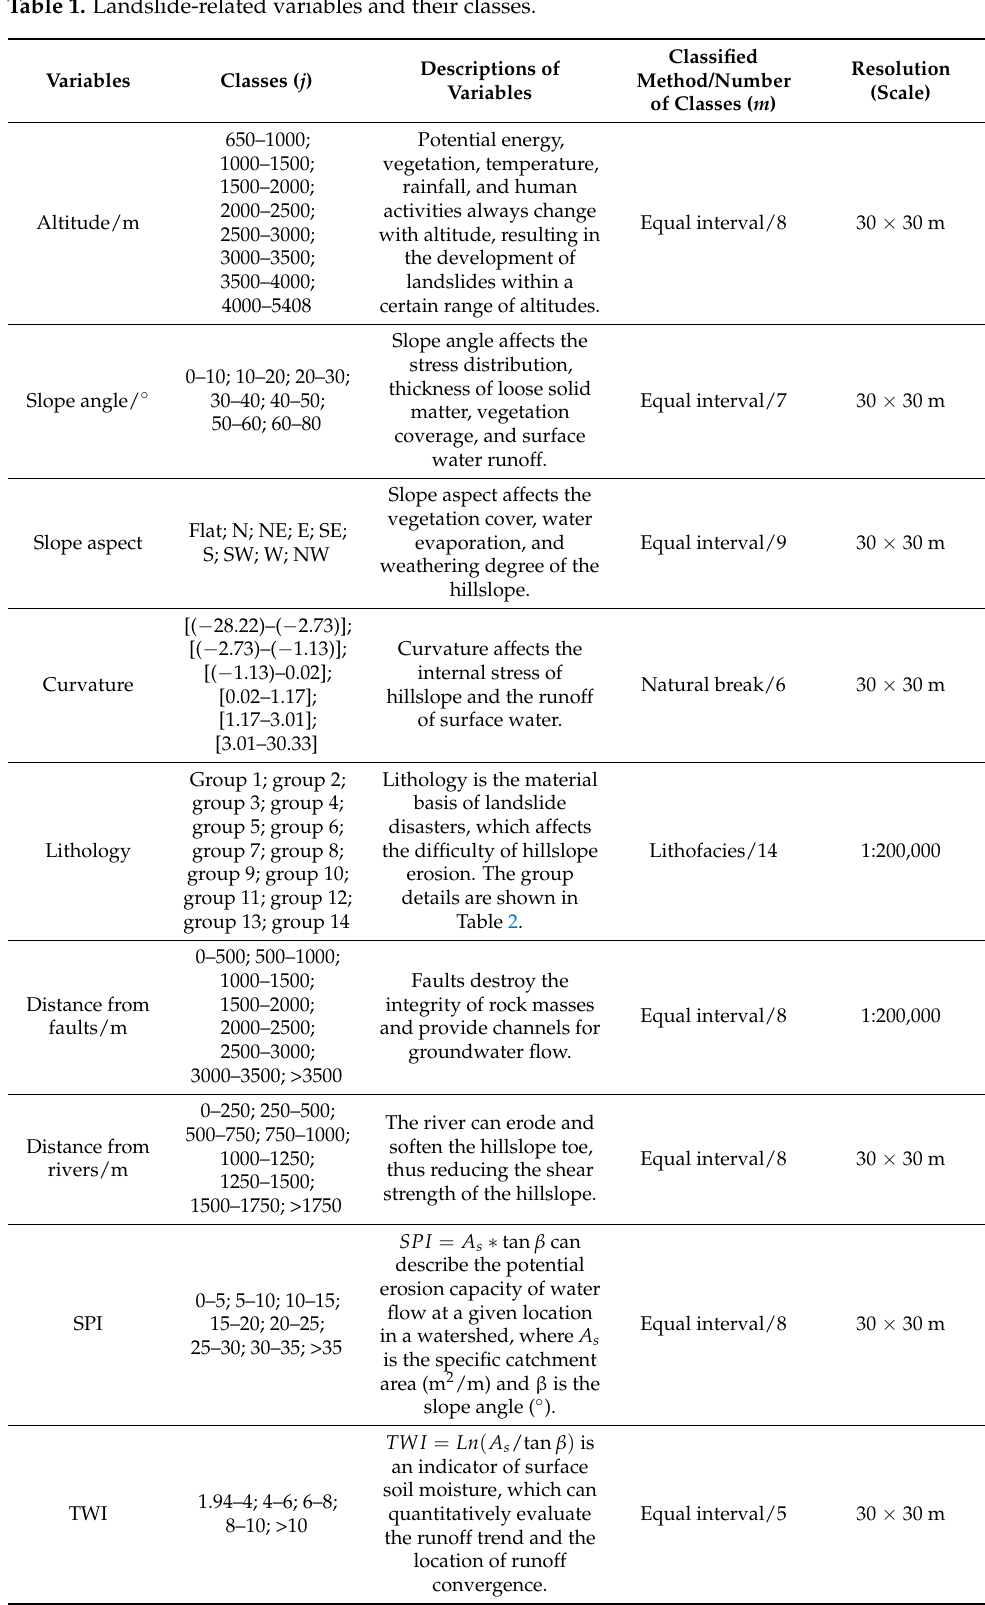
Table 1. Landslide-related variables and their